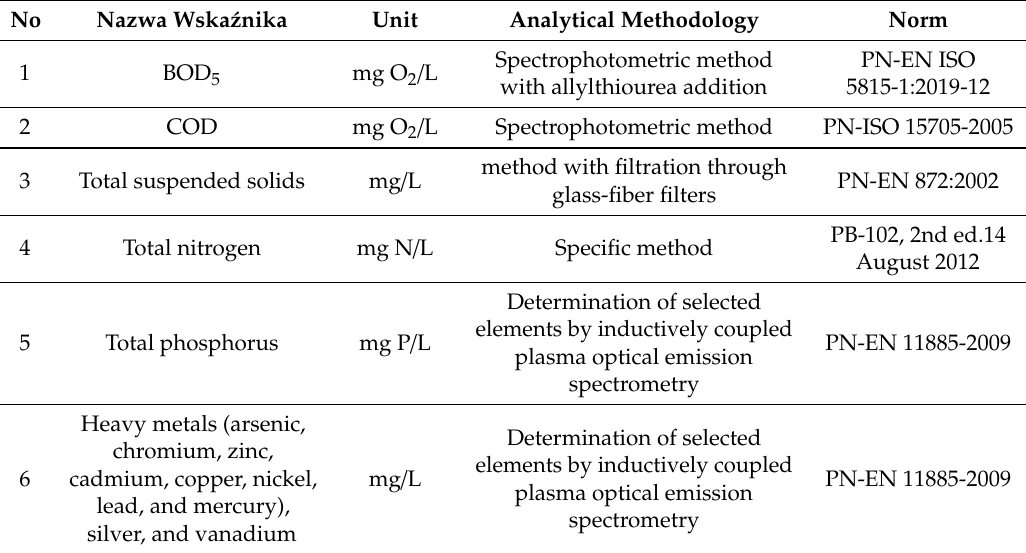
Table 5. Norms and methods used for analytical pollution